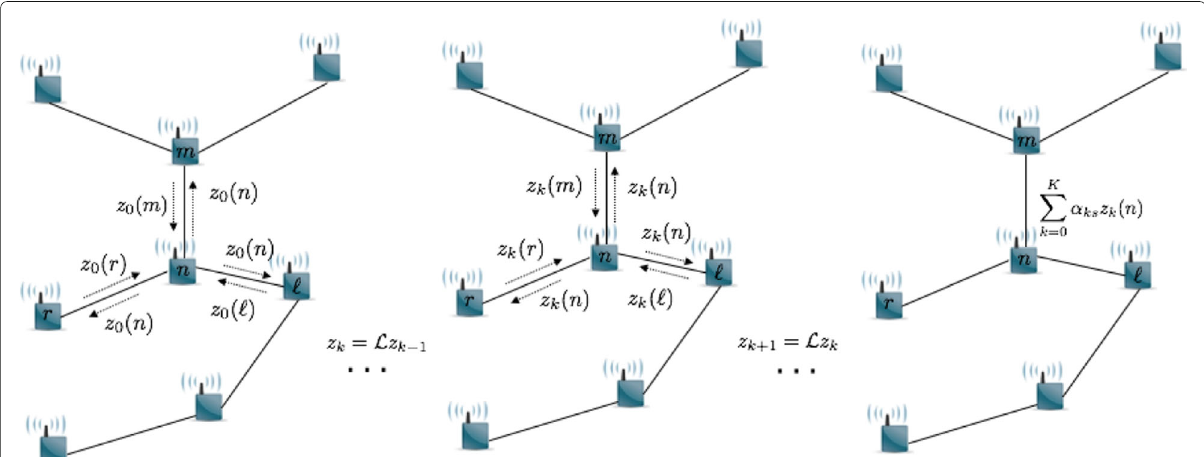
Fig. 1 Distributed computation of D s y in a sensor network. Sensor n exchanges messages with its one-hop neighbors for K iterations. After each iteration, the received messages are filtered with weights defined by the graph Laplacian, i.e., z k ( n ) = ( L z k − 1 )( n ) , and are transmitted locally in the network. ( D s y )( n ) is computed as a linear combination of the messages exchanged during the K iterations (cid:10) K α ( n ) . The same can be done for the differ- sk z k k = 1